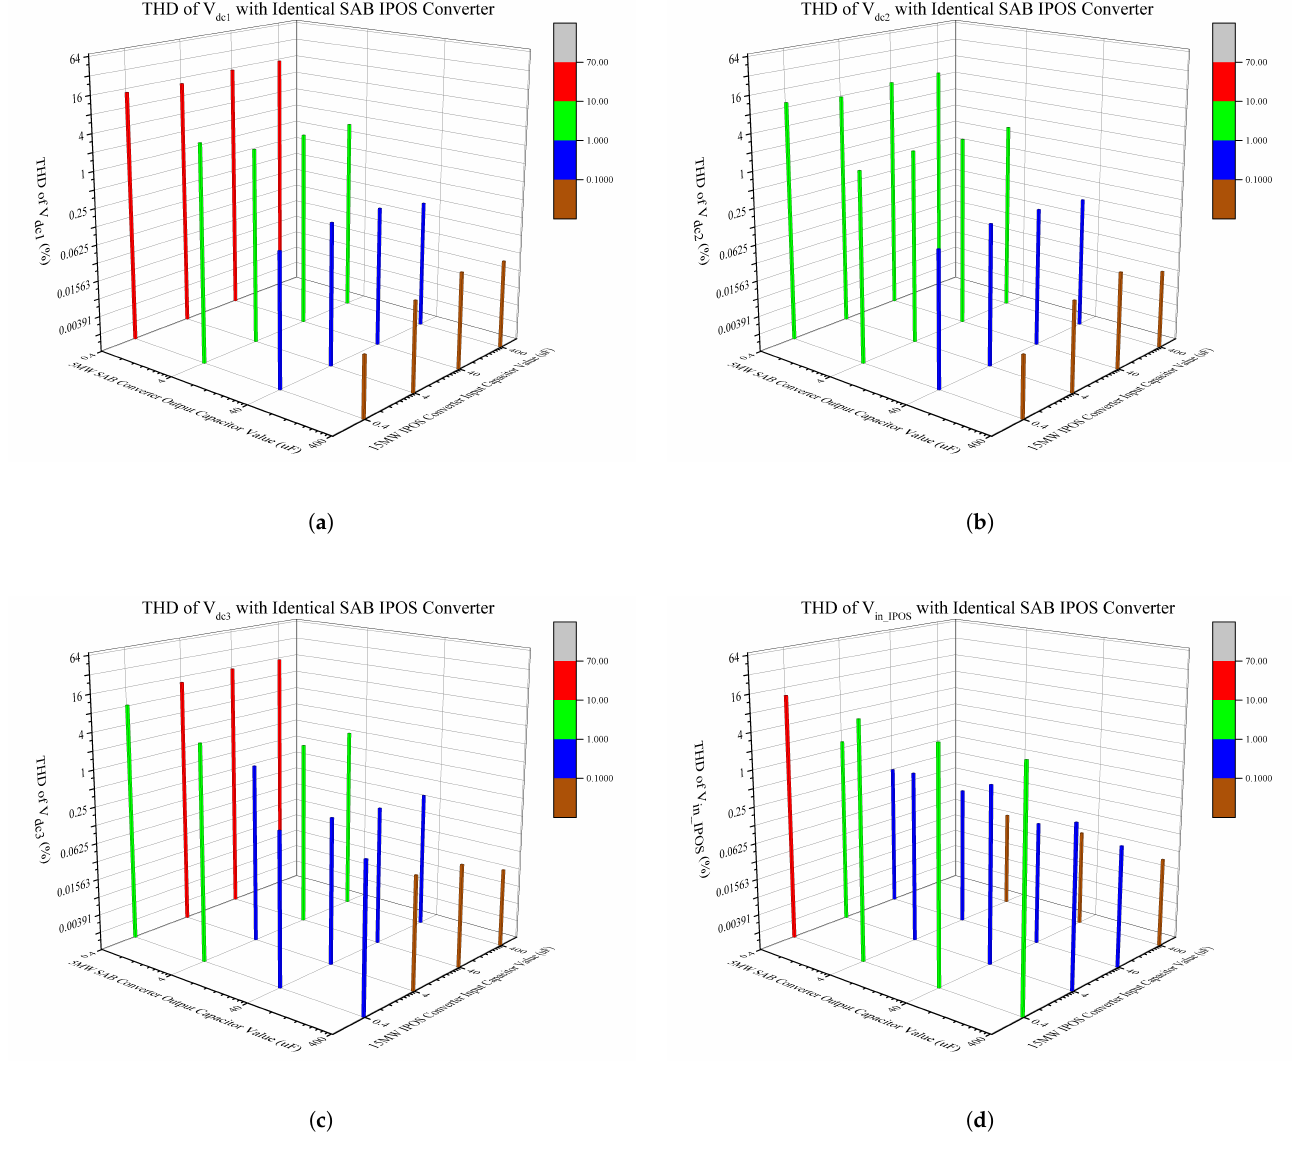
Figure 7. Total harmonic distortions of terminal voltages in Figure 2 in different filter capacitor values with identical SAB IPOS Converter. ( a ) Total harmonic distortions V dc1 ; ( b ) total harmonic distortions V dc2 ; ( c ) total harmonic distortions V dc3 ; and ( d ) total harmonic distortions V in_IPOS